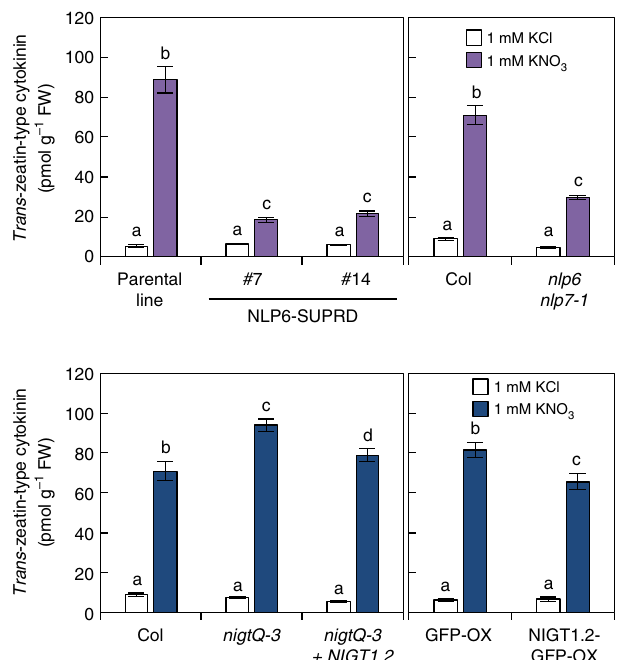
Fig. 5 NLP and NIGT1 activity affects tZ-type cytokinin content. Cytokinin contents in the seedlings treated with 1 mM KNO 3 or KCl for 24 h were measured. The cytokinin contents in two NLP6-SUPRD lines were compared with those in its parental line (4xNRE-35Smin-GUS) 21 , and the cytokinin contents in the nlp6 nlp7-1 mutant, the nigt1 quadruple mutant ( nigtQ-3 ), and the complementation line of nigtQ-3 , which was produced by expression of NIGT1 . 2 , were compared with those in Col seedlings. The cytokinin contents in the NIGT1 overexpressor (NIGT1.2-GFP-OX), which was produced by the overexpression of NIGT1.2 fused to GFP, were compared with those in the GFP overexpressor line (GFP-OX). Values are mean ± s.d. ( n = 4~5). Different letters denote signi fi cant difference by Tukey ’ s HSD ( p < thereby they are candidates for the genes whose expression is